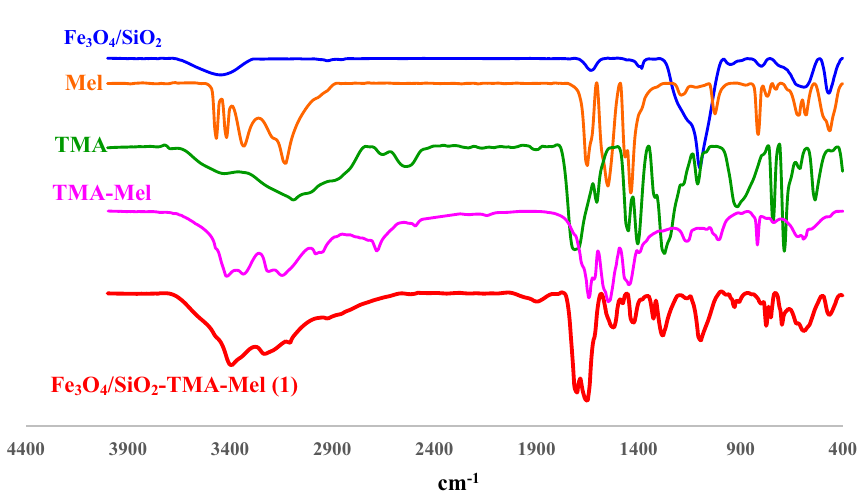
Figure 3. FTIR spectra of the Fe 3 O 4 /SiO 2 , melamine (Mel), trimesic acid (TMA), melamine-trimesic acid amide (Mel-TMA) and Fe 3 O 4 /SiO 2 -TMA-Me solid acid ( 1